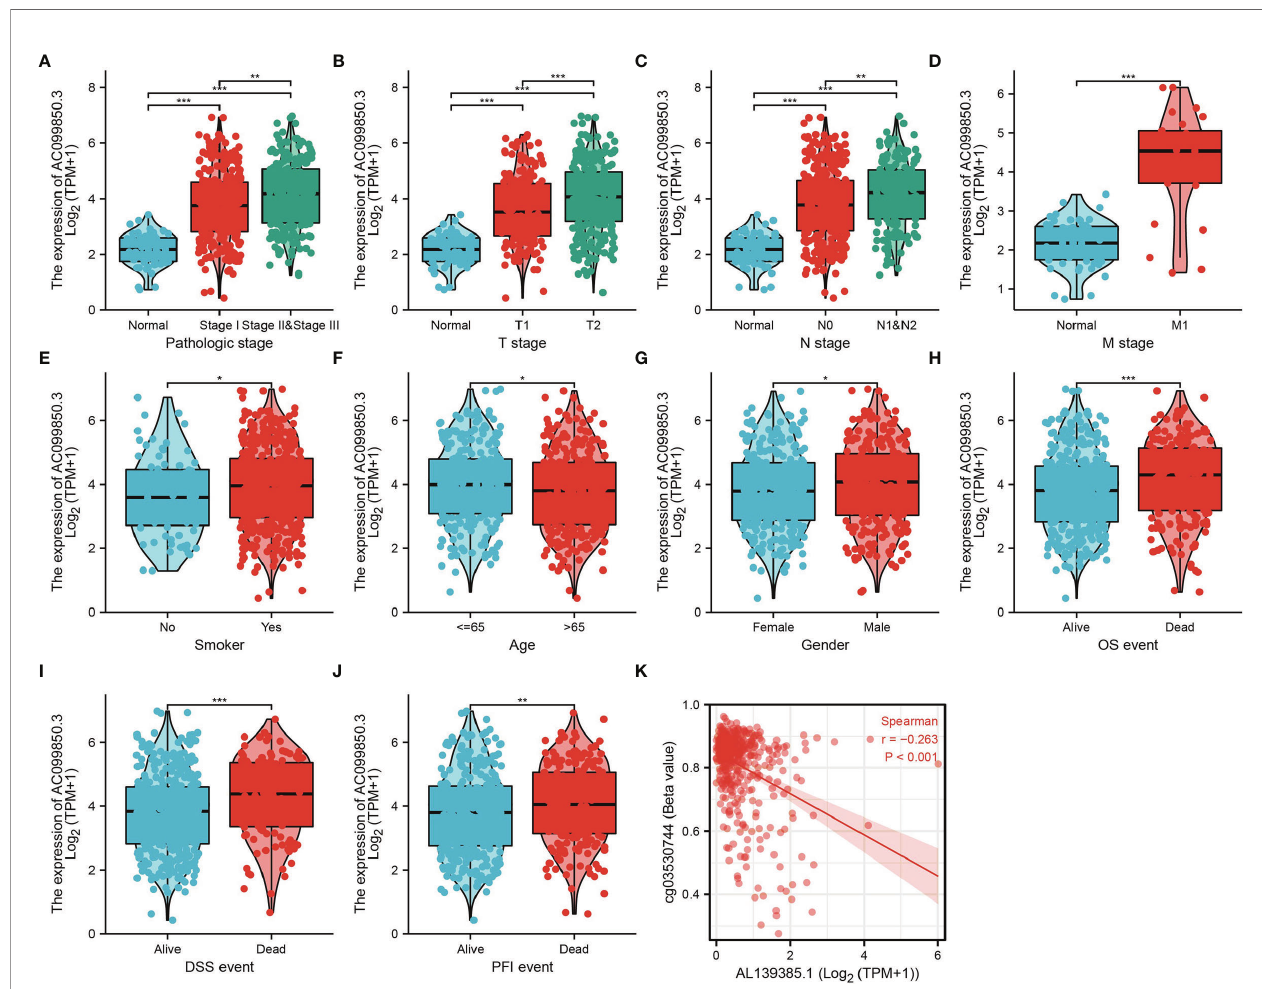
FIGURE 2 | Clinical signi fi cance of AC099850.3 in LUAD. (A – J) Correlation between AC099850.3 expression and clinical parameters, including the pathological stage, TNM stage, smoking, age, gender, OS event, DSS event, and PFS event. (K) AC099850.3 expression is negatively correlated with mean AC099850.3 promoter